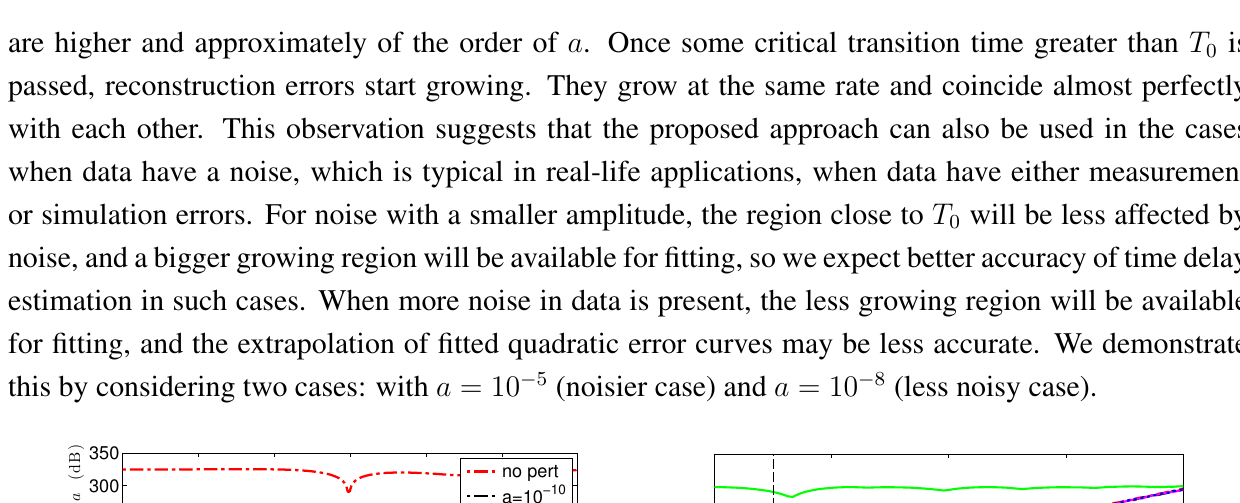
|| in the four-pole R ∞